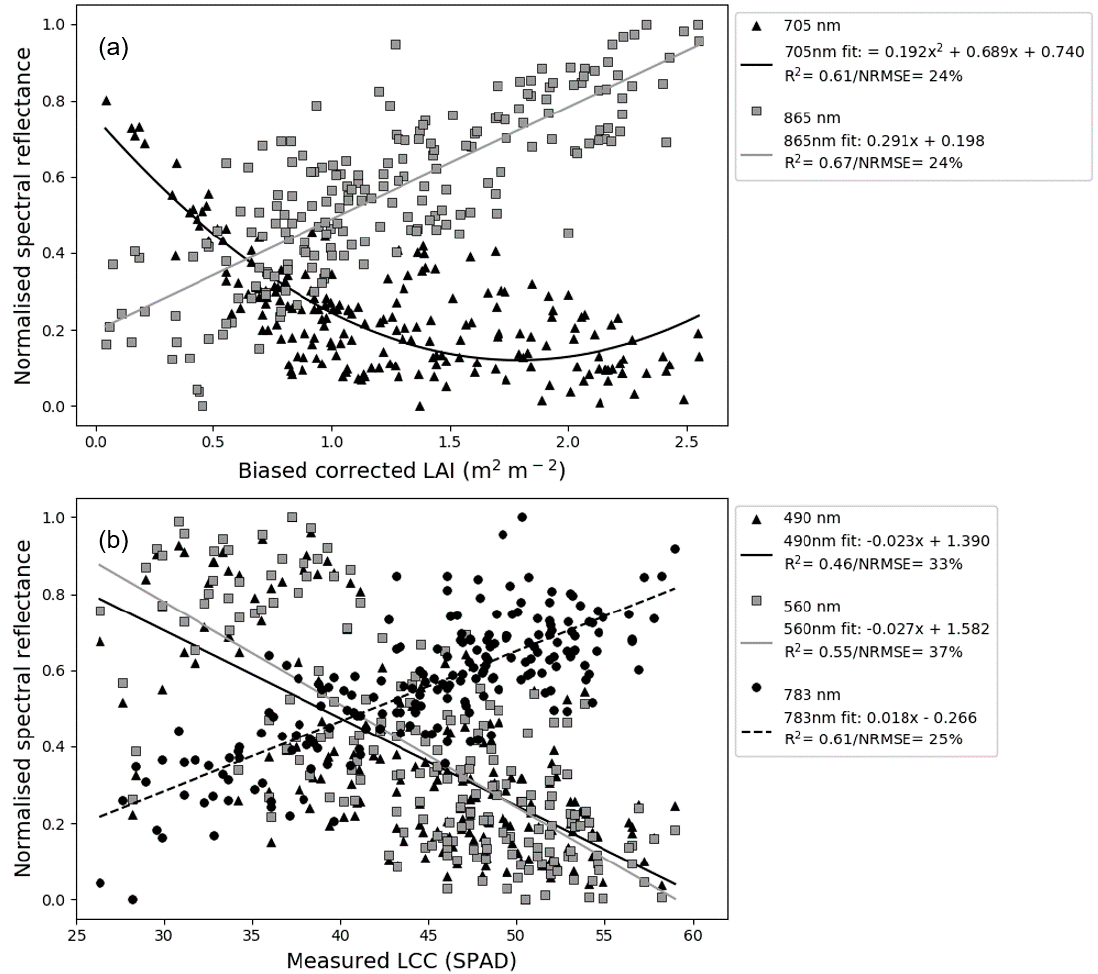
Figure 4. Comparison of the normalised spectral responses and regression analysis between the most sensitive MAIA / Sentinel-2 bands and non-destructive ground measurements of ( a ) bias corrected LAI and ( b ) LCC. Table 3. Summary of regression analysis statistics, including the coefficient of determination (R 2 ) and normalised root-mean-square-error (NRMSE), from comparing single-band and multivariate linear regression and Gaussian processes regression (GPR) modelling for retrieving ground measurements of LAI and LCC.